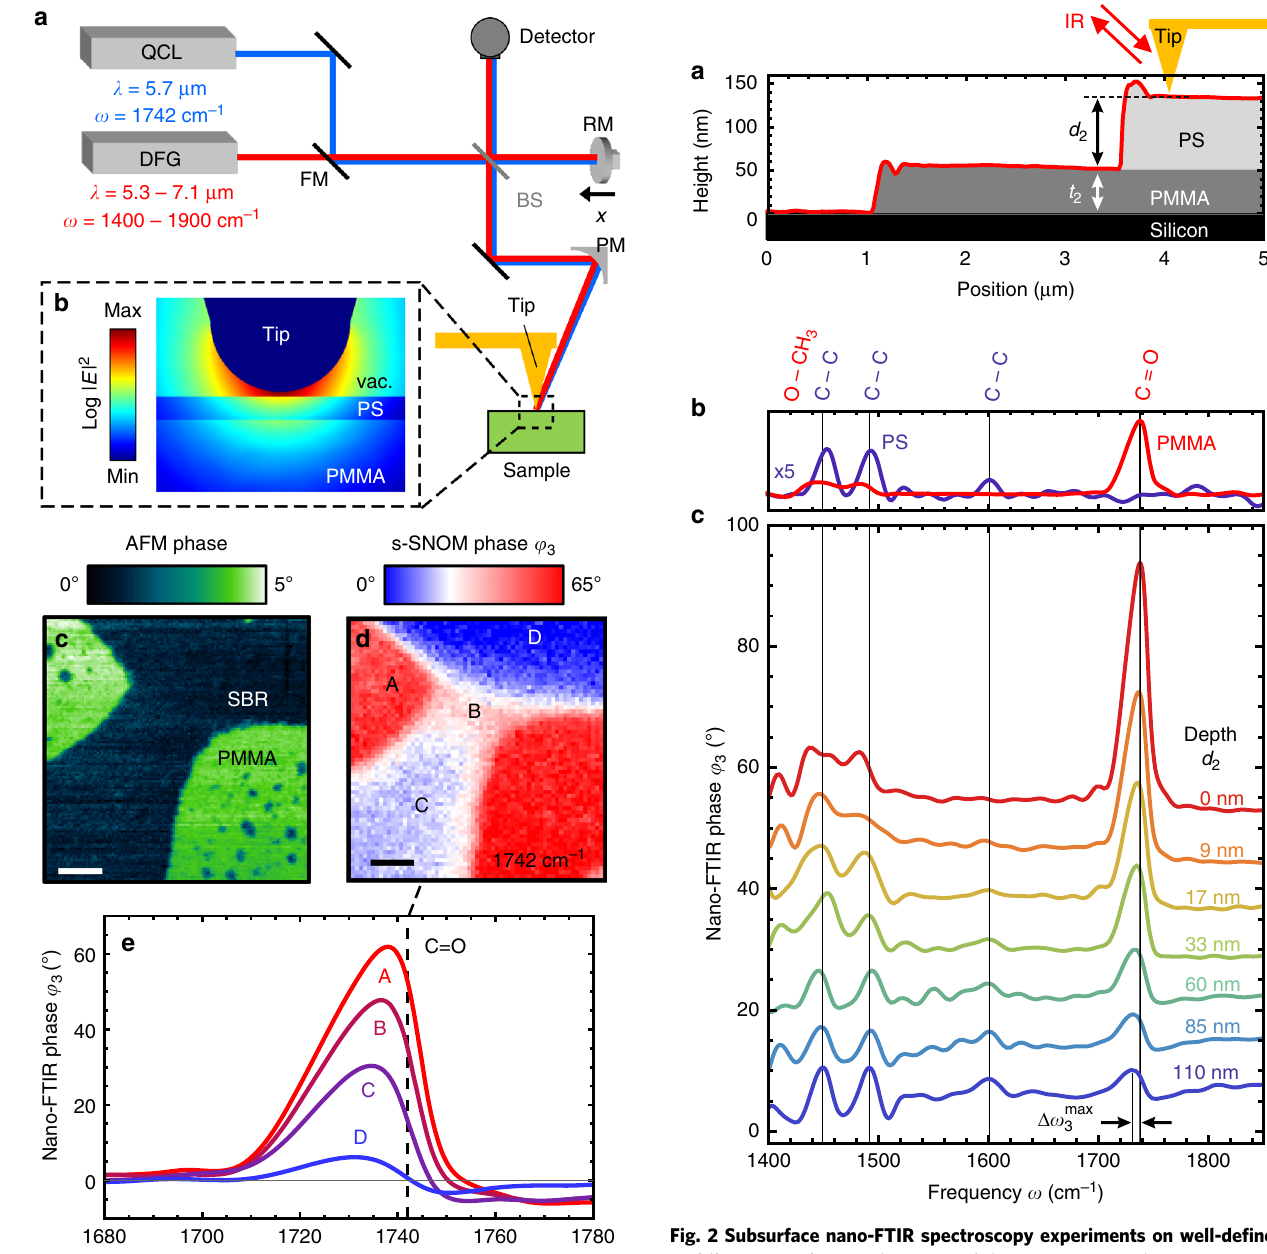
Fig. 2 Subsurface nano-FTIR spectroscopy experiments on well-de fi ned multilayer samples. a Schematics of the experiment and PMMA/PS test sample, including the topography line pro fi le of a d 2 = 85 nm-thick PS layer covering the t 2 = 59.4 nm-thick PMMA layer on Si. b Reference nano-FTIR phase spectra recorded on thick PMMA and PS layers. c Subsurface nano- FTIR phase spectra of PMMA at different depths d 2 below PS (average of 50 spectra (80 spectra for d 2 ≥ 85 nm), 30 s acquisition time per interferogram, ×128 zero fi lling, 17 cm − 1 spectral resolution). Black arrows in c indicate the spectral peak shift Δ ω max . 3 vibrations in the O − CH 3 group. Characteristic for PS are the two distinct absorption lines at 1452 cm − 1 and 1493 cm − 1 (and a weaker mode at 1601 cm − 1 ), which arise from C − C stretching vibrations in the aromatic ring 38 . The reference spectrum of PS does not exhibit any phase contrast around 1700 – 1800 cm − 1 , i.e., it is spectrally fl at, which simpli fi es the following discussion. Figure 2c shows subsurface nano-FTIR spectra of PMMA at different depths d 2 below PS. Without a capping layer (red, d 2 = 0), we clearly observe the characteristic C = O and O − CH 3